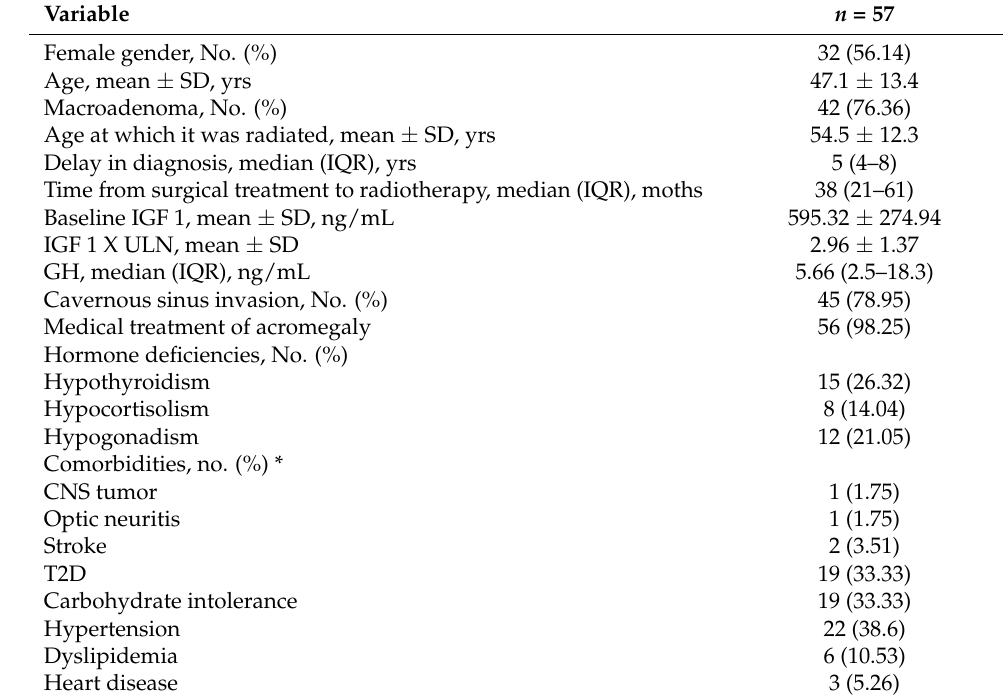
Table 1. Baseline characteristics of patients with acromegaly treated with radiosurgery ( n =